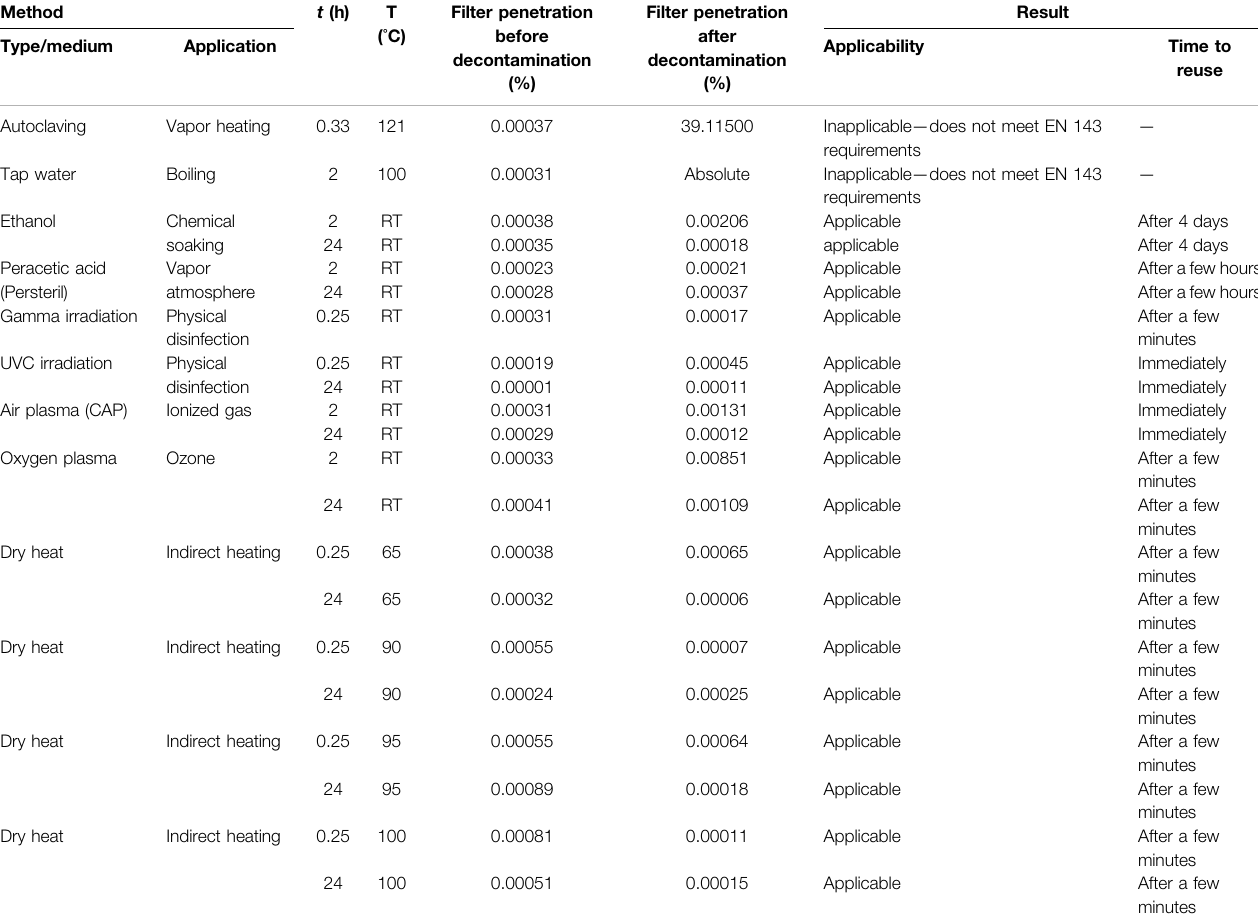
TABLE 1 | Characteristics of P3 R fi lters upon application of different disinfection methods P3R fi lters in cartridges (Supplementary Figure S1) were exposed to different disinfection methods and the fi ltration ef fi ciency wasmeasured byaerosolpassageaccording to the standards EN 143 and EN 149, as outlined in the Methods